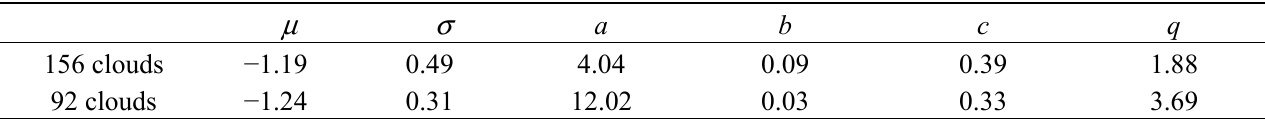
Table 2. Related parameters for the three fitted probability density functions (PDFs) of entrainment rate ( λ ) in Figure